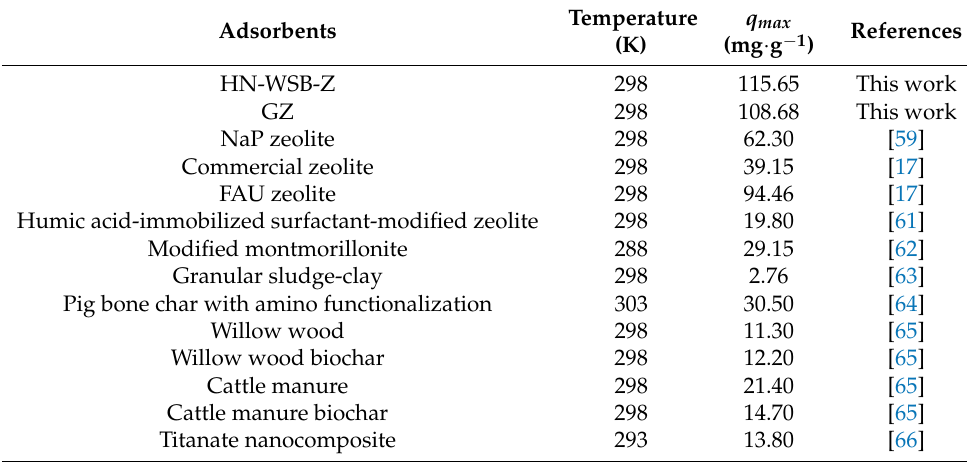
Table 3. Comparison of maximum Cu(II) adsorption capacities ( q max ) by various adsorbents.